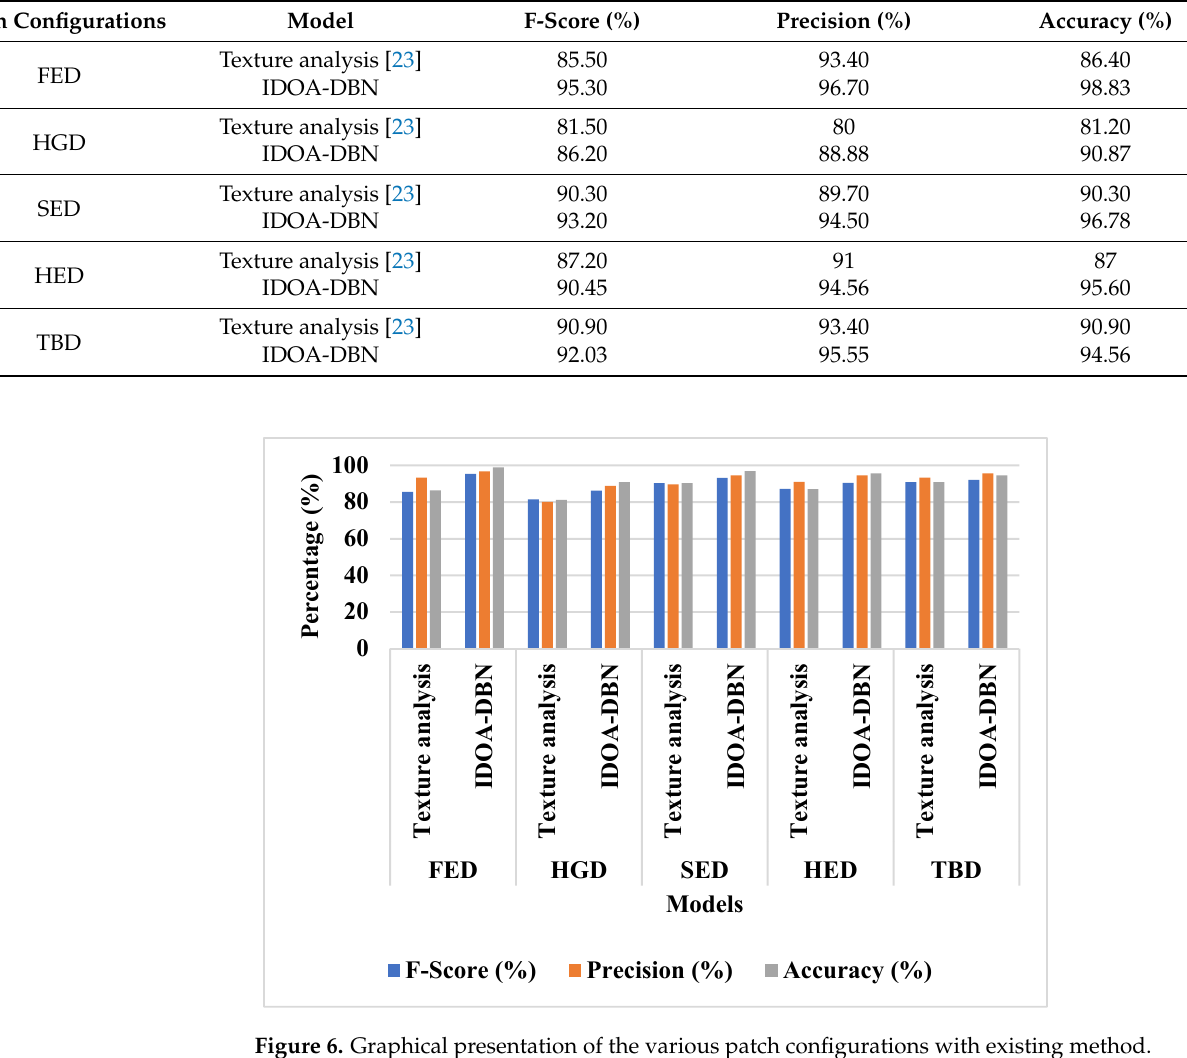
Table 5. Comparative analysis of accuracy with existing method.